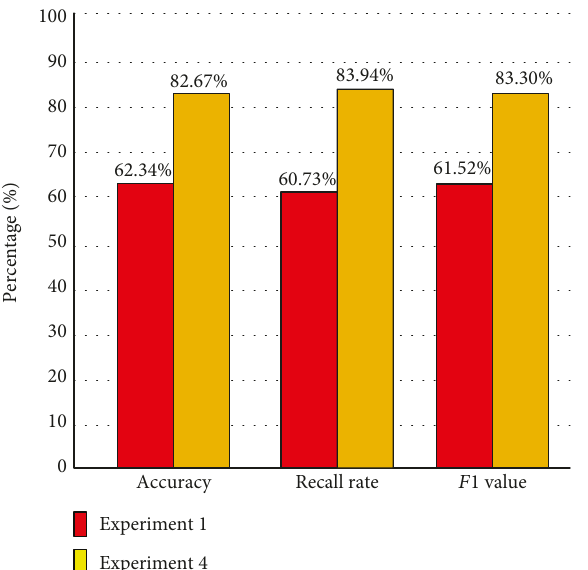
Figure 4: Comparison of Experiment 1 and Experiment 4.